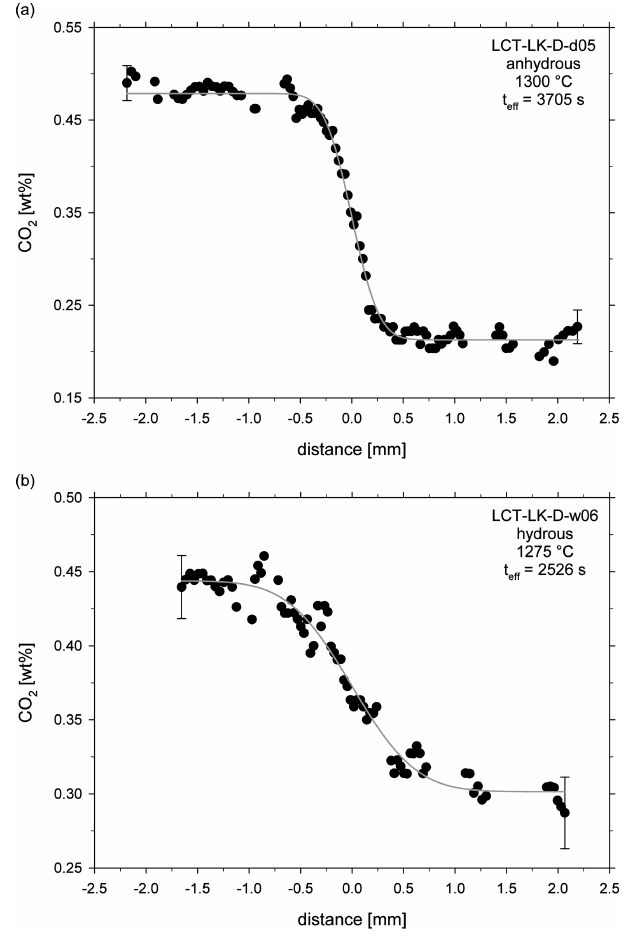
Figure 5. CO 2 diffusion profiles of (a) an anhydrous diffusion sam- ple (LCT-LK-D-d05) and (b) a hydrous diffusion sample (LCT- LK-D-w06); distance = 0mm marks the initial contact plane of the melts; the grey lines represent the fitted complementary error func- tions from which the diffusion coefficients were extracted; error bars are representative for 2 σ errors of repeated